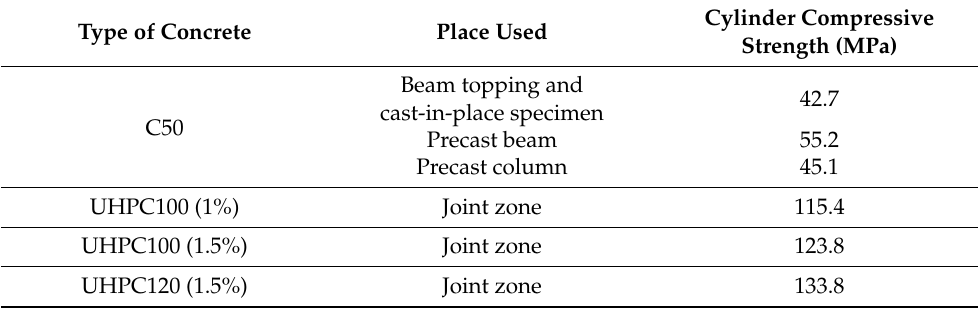
Table 3. Concrete material